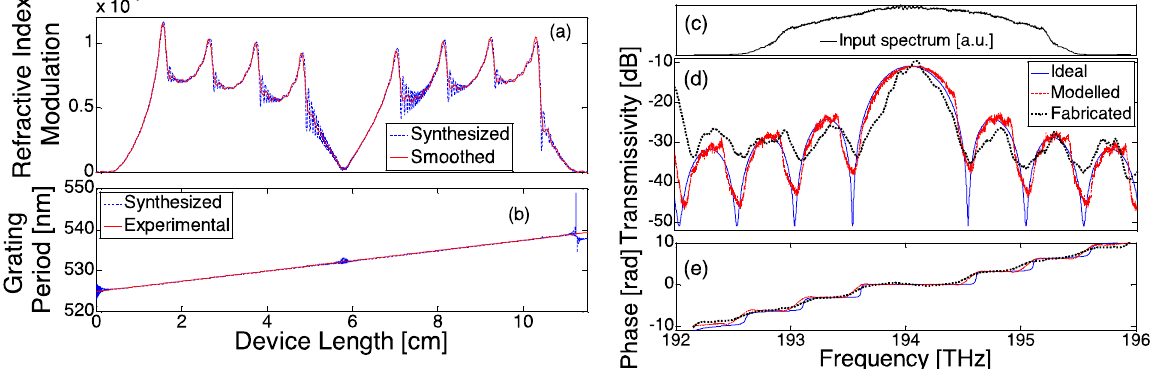
Figure 11. Apodization profile ( a ) and period ( b ) of a rectangular pulse-shaper implemented on an FBG in transmission. The curves obtained from the synthesis algorithm are in blue, while smoothed profiles adapted to the restrictions of the fabrication method (sub-mm resolution) are in red; ( c ) Spectrum of the experimental input signal; ( d ) transmissivity and ( e ) ideal phase of the spectral response in transmission (blue line), analytical response restrained to fabrication limitations (red line) and experimentally measured response (dotted black line).